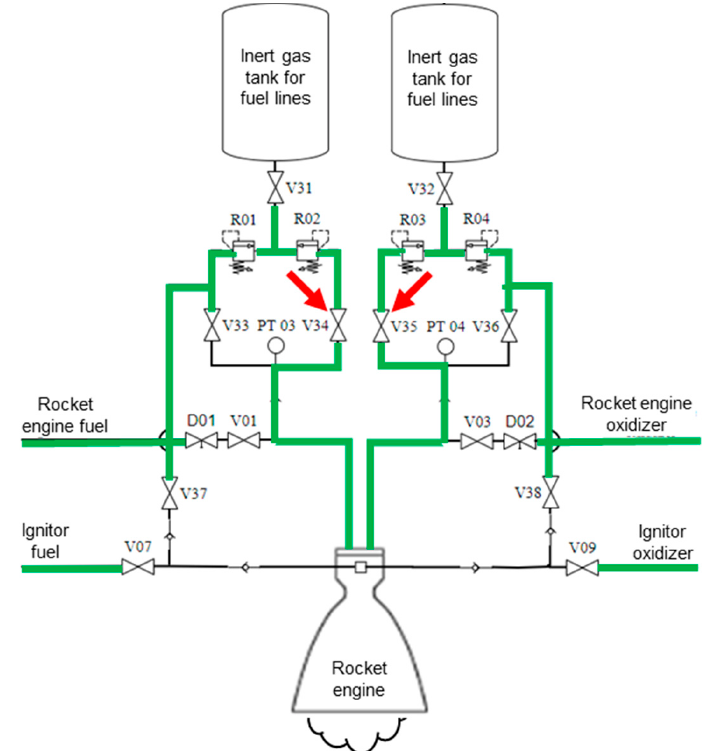
Figure 31. Algorithm’s 12th step diagram.